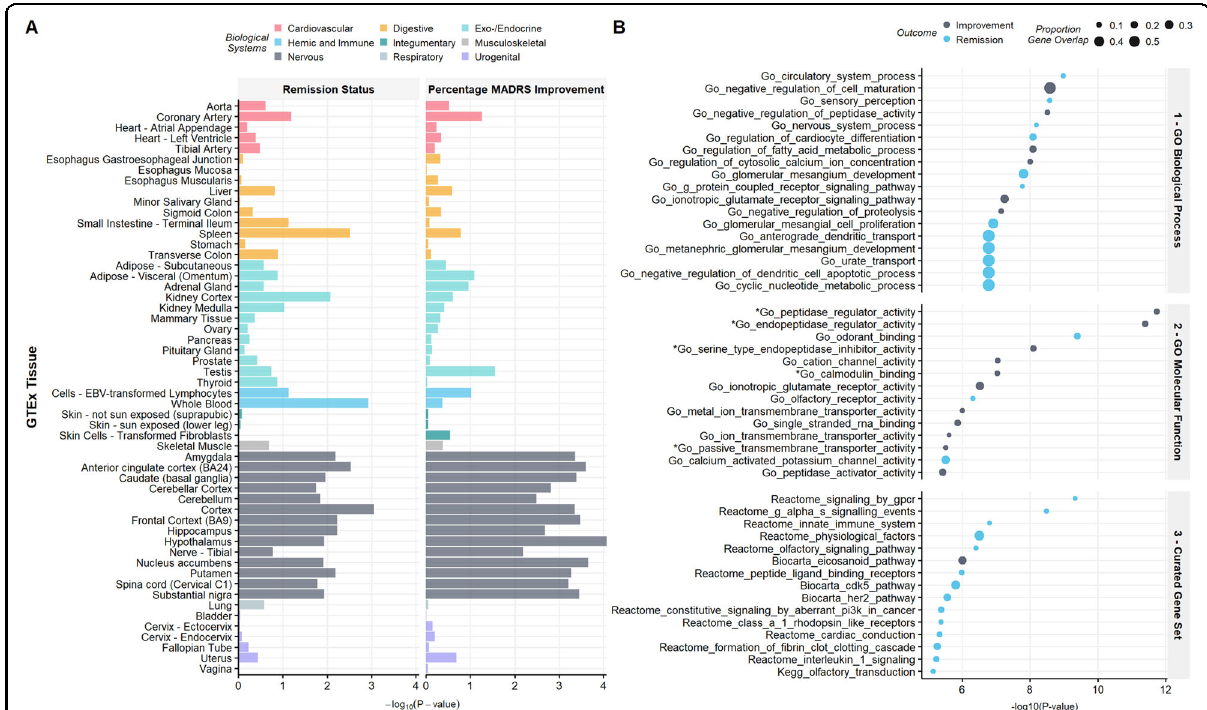
Fig. 4 GTEx tissue and geneset enrichment for nominally associated genes with remission status ( n = 878) or percentage symptom improvement ( n = 889). A GTEx tissue ( n = 54) enrichment. B Enrichment across Gene Ontology and curated genesets. For genesets, only the top 15 sets are shown across both remission status and percentage symptom improvement for brevity. No signi fi cant enrichment was observed for tissue or genesets. *Note. Pathways also among the top 15 associated for the second phenotype (either remission status or improvement, as indicated) but at a lower p